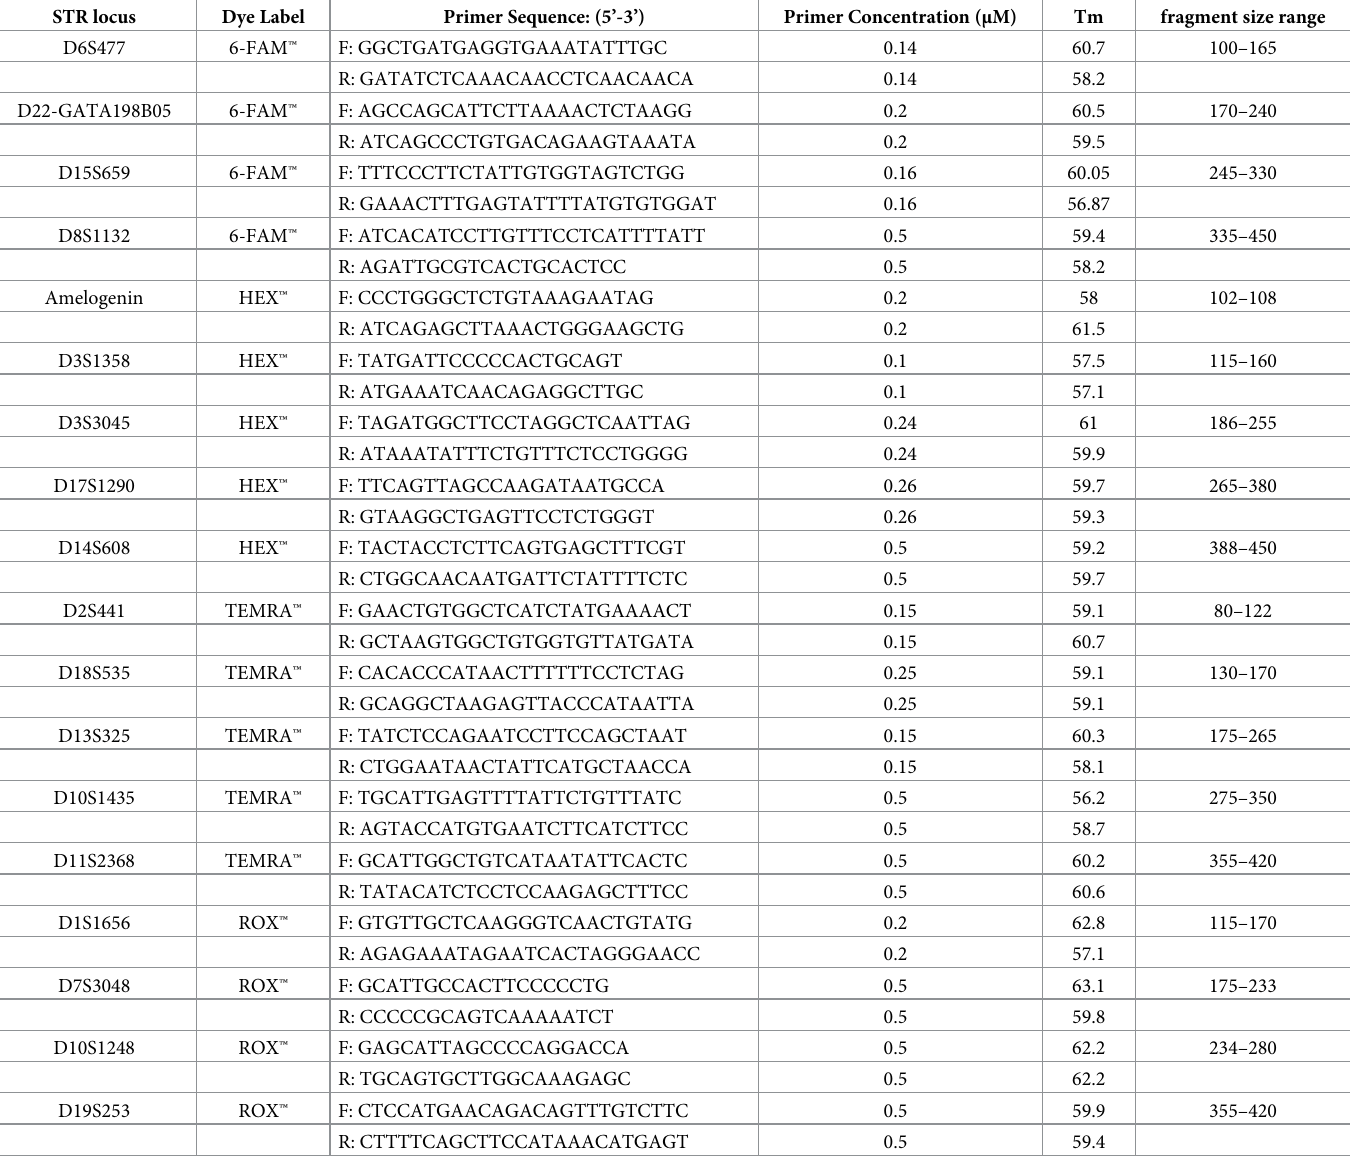
Table 1. Primer information of STR loci included in the new studied